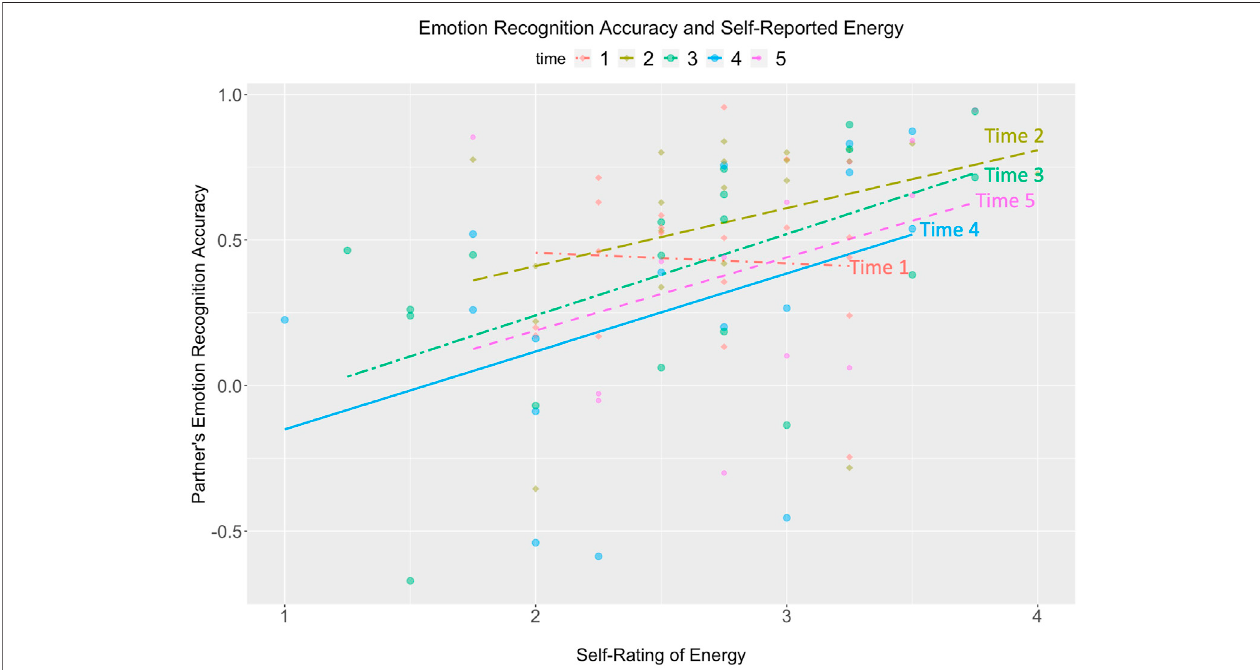
FIGURE 8 | Accuracy of emotion recognition negatively correlated with self-reported anxiety. For this plot, items were reverse-coded to make it easier to interpret (1: De fi nitely not to 4: De fi nitely). Y axis show correlation rates.